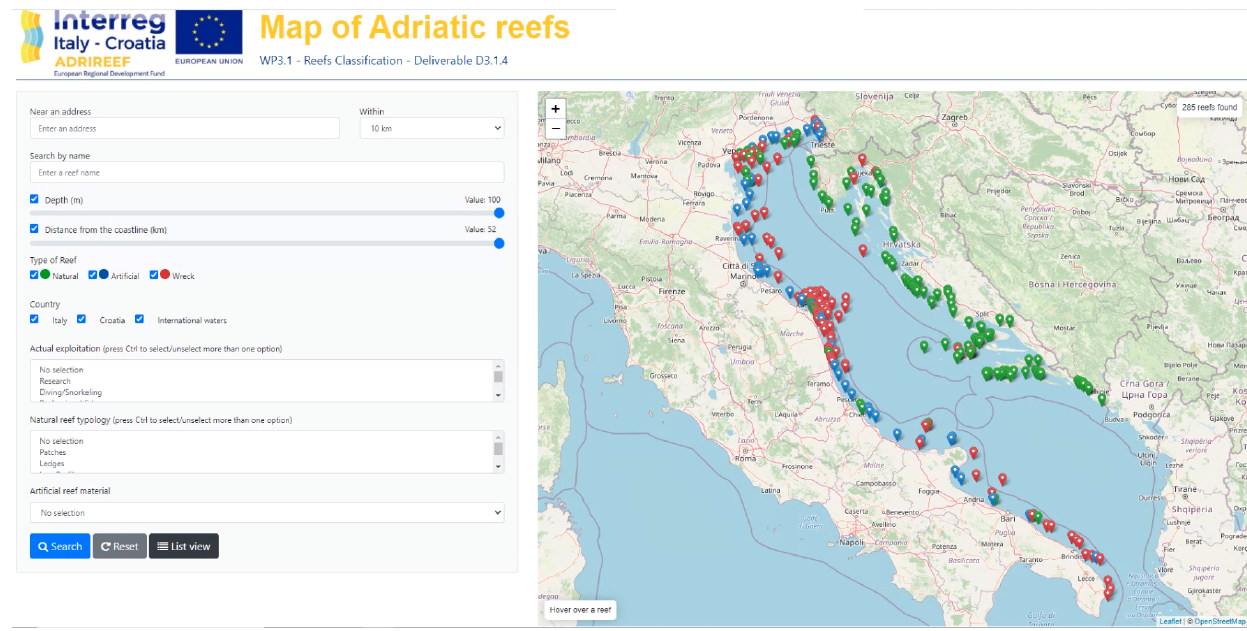
Figure 1. The WebGIS interface. On the left side: the filter window. On the right side: the map window with hover function (bottom left) and the total number of identified elements (top right). Basemap credits: © OpenStreetMap contributors 2020. Distributed under a Creative Commons BY-SA License.